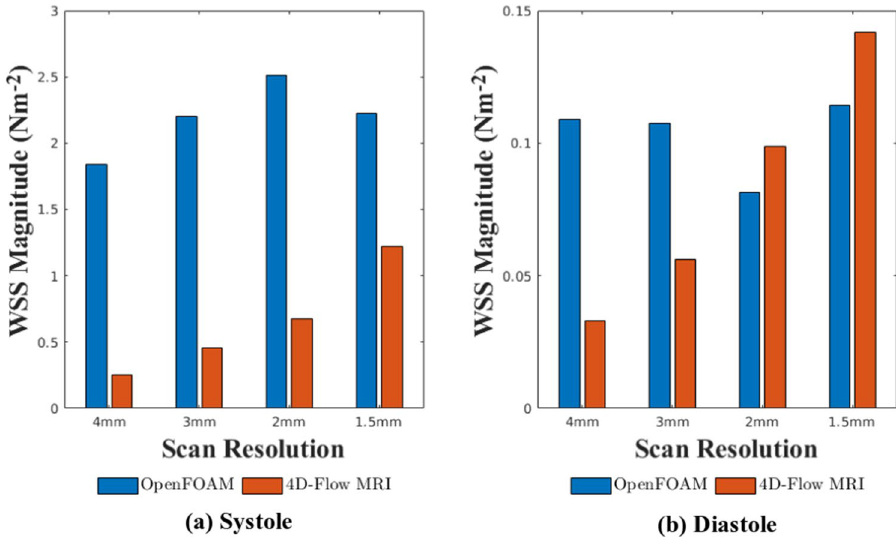
Figure 9. Average wall shear stress magnitude over eight locations of the vessel wall for a plane in the mid- ascending aorta, calculated with 4D-Flow MRI and CFD data for all spatial resolutions during systole and